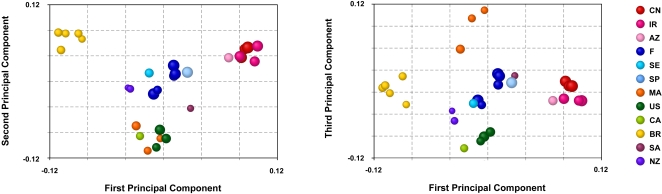
Principal component analysis of a matrix of chord distance [67] among 29 samples of multilocus microsatellite haplotypes of Venturia inaequalis.
The first, second and third principal components account for 23.2%, 20.9% and 18.7% of variance respectively. For each samples, the diameter of the disk is proportional to allelic richness. CN = China, IR = Iran, AZ = Azerbaijan, F = France, SE = Sweden, SP = Spain, MA = Morocco, US = USA, CA = Canada, BR = Brazil, SA = South Africa, NZ = New Zealand.